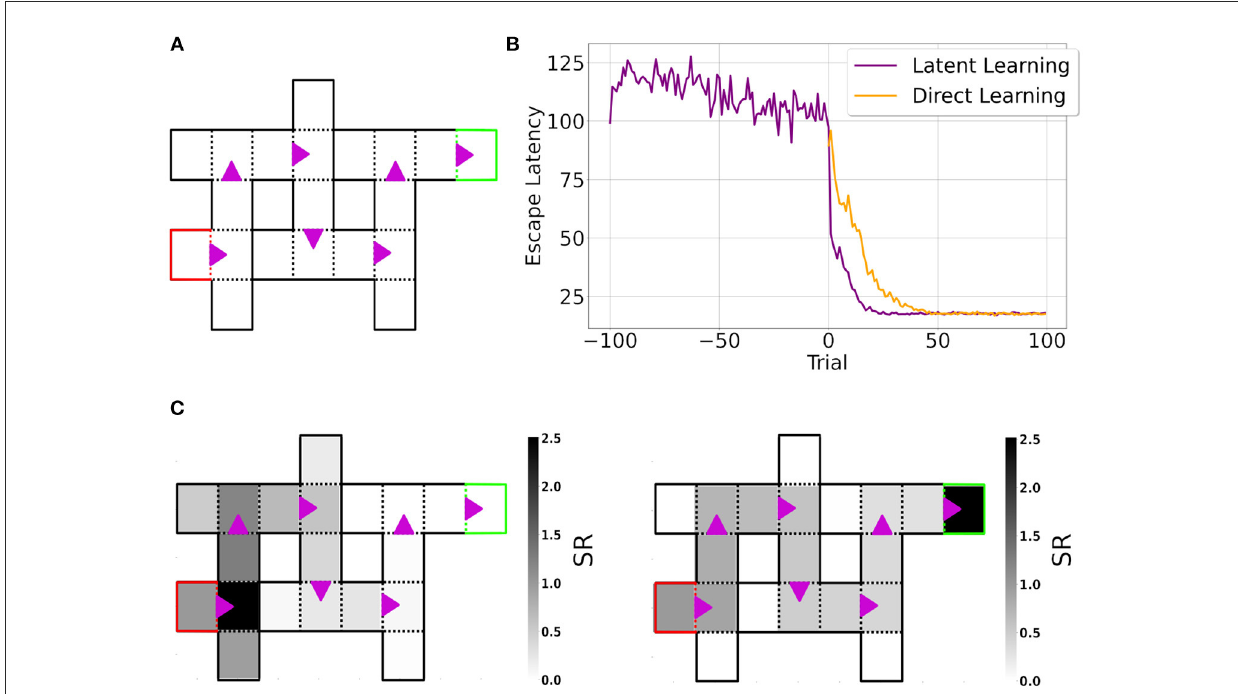
FIGURE7 Simulation of latent learning using CoBeL-RL. (A) Gridworld of the Blodgett maze. The red and green squares represent the start and goal states, respectively. Purple arrows indicate transitions that are only allowed in the indicated direction. (B) Escape latency of agents trained in latent learning (purple) and direct learning (orange) settings. For better comparison, the curve for the direct learning setting was shifted to the point of reward introduction of the latent learning setting. Curves represent means over 30 simulations per agent. (C) Learned Deep SR of the start state at the end of the training phase (left) and at the end of the simulation (right). At the end of the training phase, the learned SR mainly represents states close to the start state. In contrast, by the end of the simulation, the learned SR represents the path to the goal state. The color bar represents the learned cumulative discounted (state)